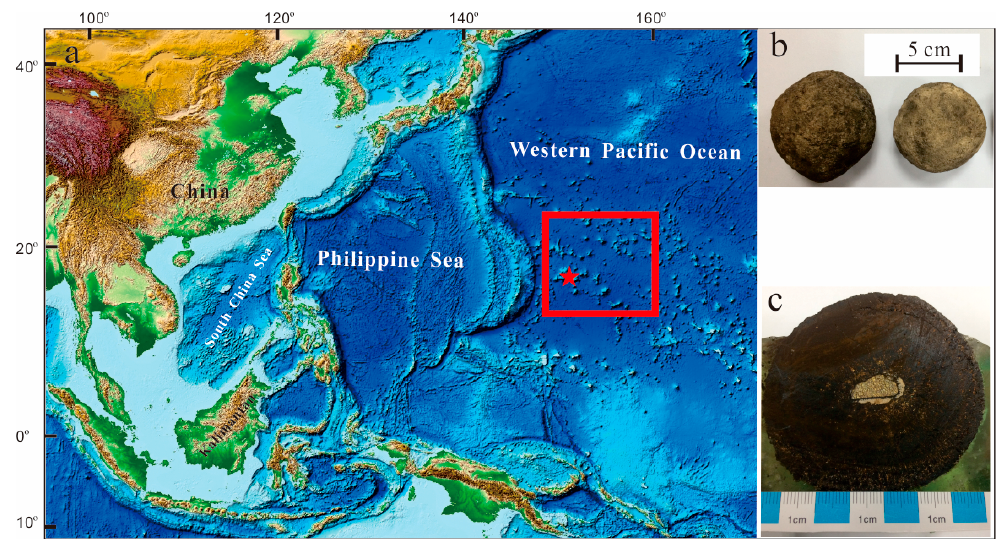
Figure 1. Sampling location map ( a ) and samples of polymetallic nodules ( b , c ). The red box indicates the cobalt-rich crust exploration contract area, and the asterisk indicates the sampling point.